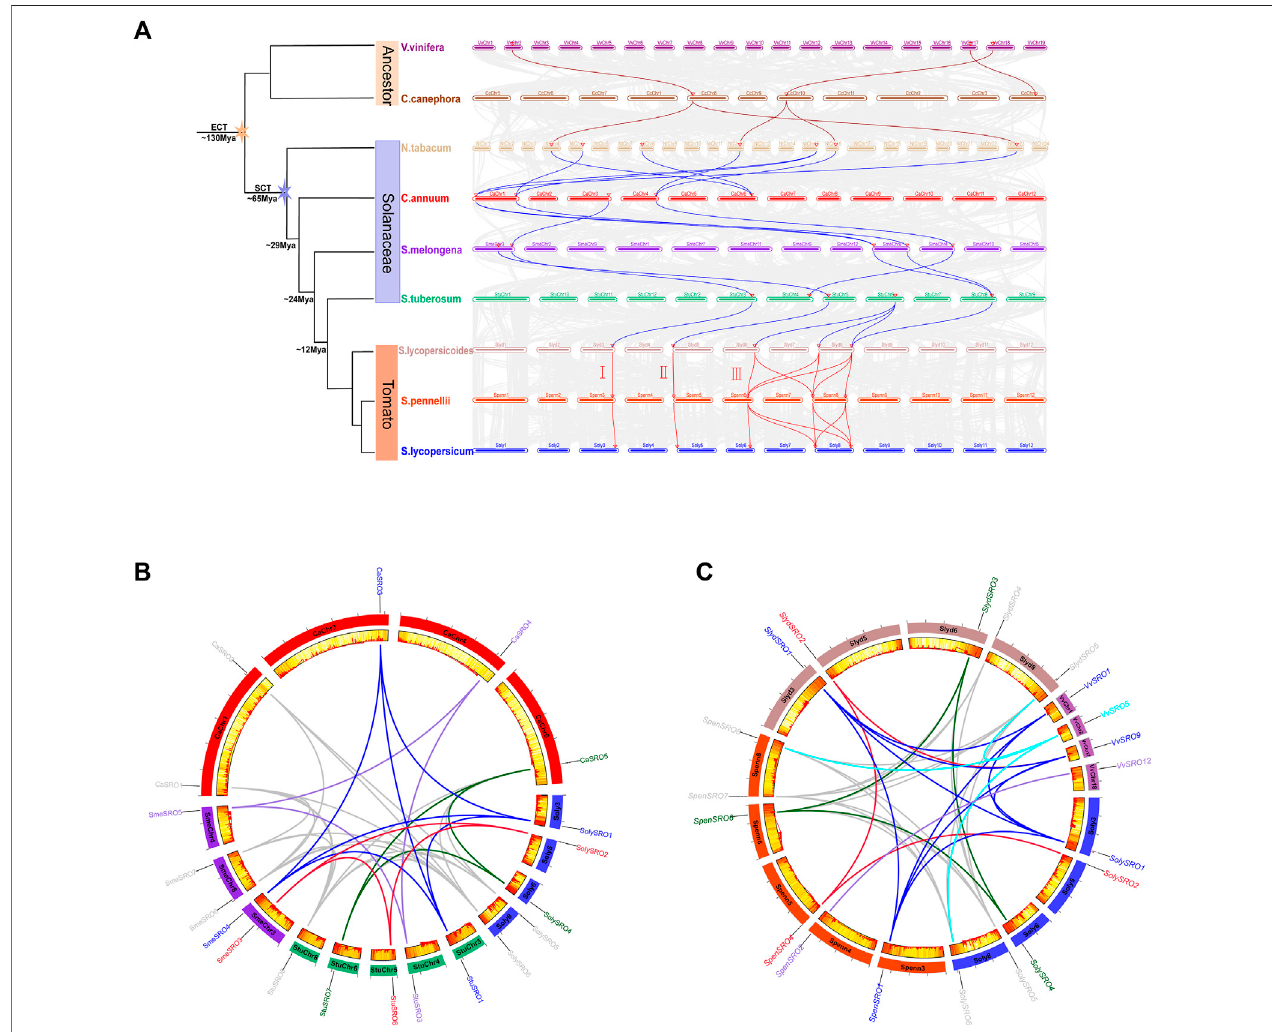
FIGURE 4 | Homologous genes and evolutionary analysis of the SRO family. (A) Co-lineage map for multiple species, with species genomes arranged in evolutionary order and coloured lines representing SRO genes with direct homologous relationships within each species. (B) Co-lineage map of SRO genes within Solanaceae ( C. annuum , S. melongena , S. tuberosum , and S. lycopersicum ), with the outer circle showing the chromosomes of each Solanaceae , the inner circle showing gene density, the ends of the lines representing direct homologous SRO genes, and the different coloured lines representing different evolutionary patterns. (C) Covarianceof SRO geneswithin V.vinifera. L, S.lycopersicoides , S.pennellii ,and S.lycopersicum ,withtheoutercircleshowingthechromosomesofeach species, the inner circle showing the gene density, the two ends of the lines representing the direct homologous SRO genes, and different coloured lines representing different evolutionary